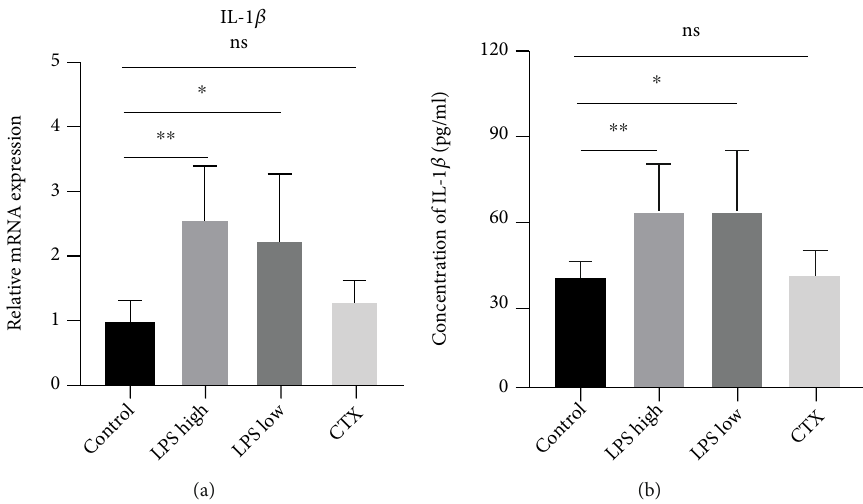
Figure 2: LPS stimulation promoted interleukin 1 β (IL-1 β ) production in mice. Mice were sacri fi ced at 2 weeks after LPS or CTX treatment. (a) Quantitative real-time PCR (qRT-PCR) was performed to determine IL-1 β mRNA expression in mouse ovary tissue samples. (b) ELISA was conducted to measure the serum IL-1 β level in mice. Data are expressed as the mean ± SEM . ∗ P < 0 : 05 and ∗∗ P < 0 : 01 ; ns: nonsigni fi cant, n = 10